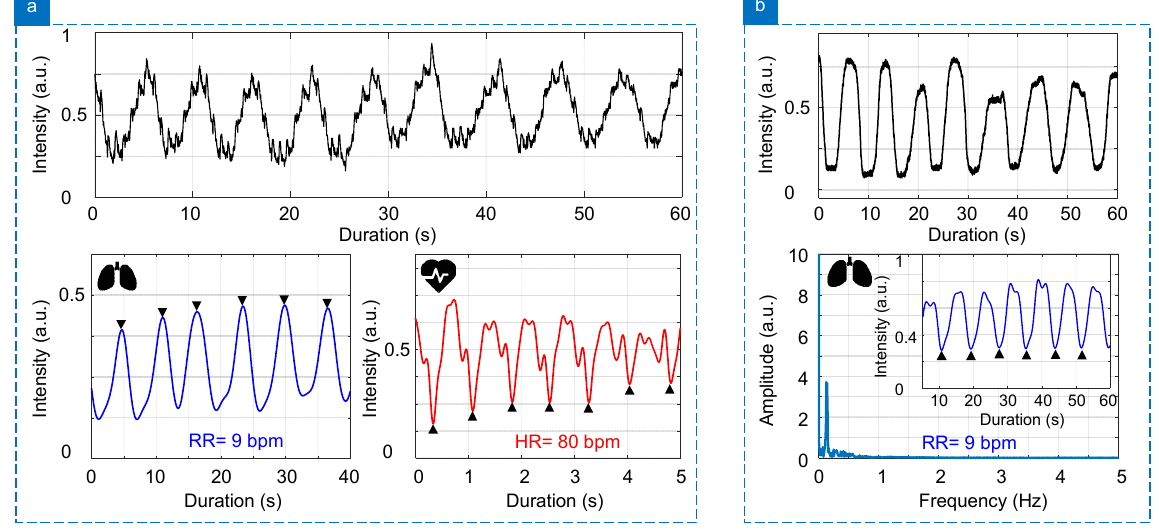
Fig. 11 | Vital signs monitoring results using the TCF interferometer, including the raw data, recovered respiration and heartbeat wave-